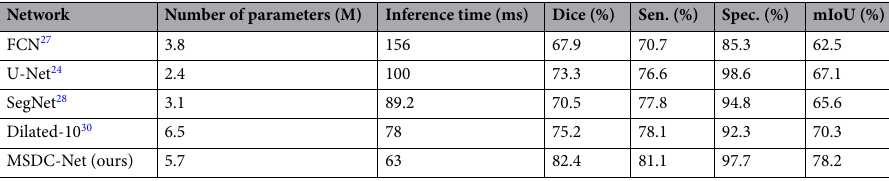
Table 4. Comparisons with existing